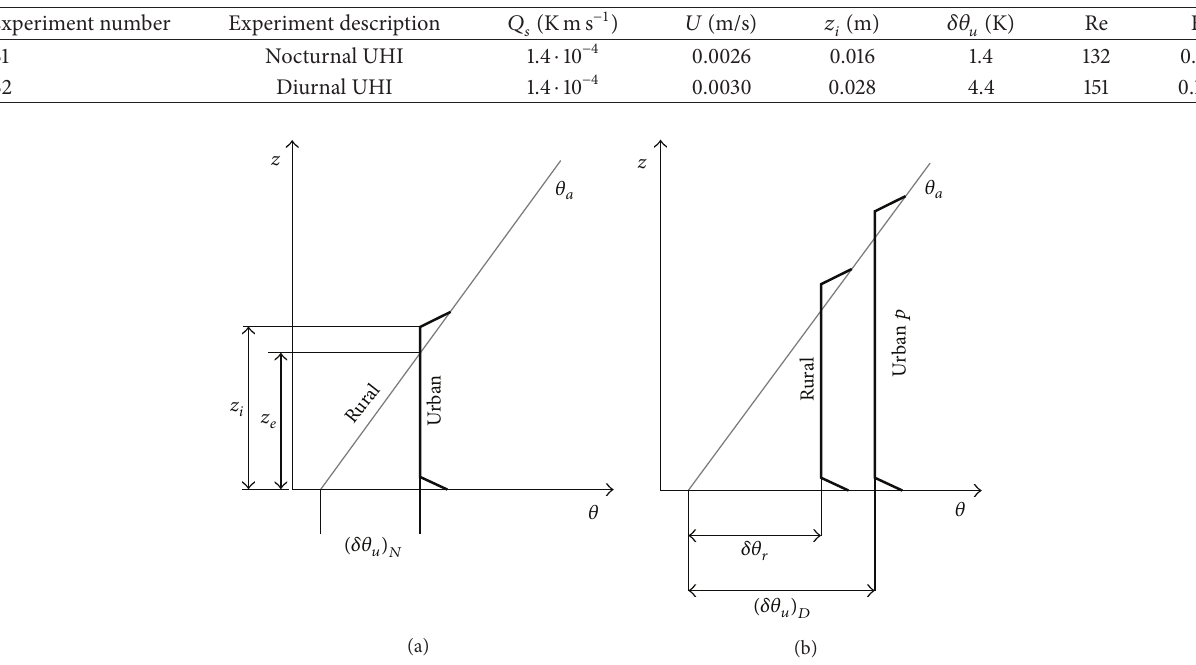
− 𝜃 ) 𝑎 𝑧=0 ; UHIaxis 𝑁 = (𝑔𝛽𝑑𝜃 /𝑑𝑧) 1/2 ≅ 0.43 s −1 are the same for all 𝑎